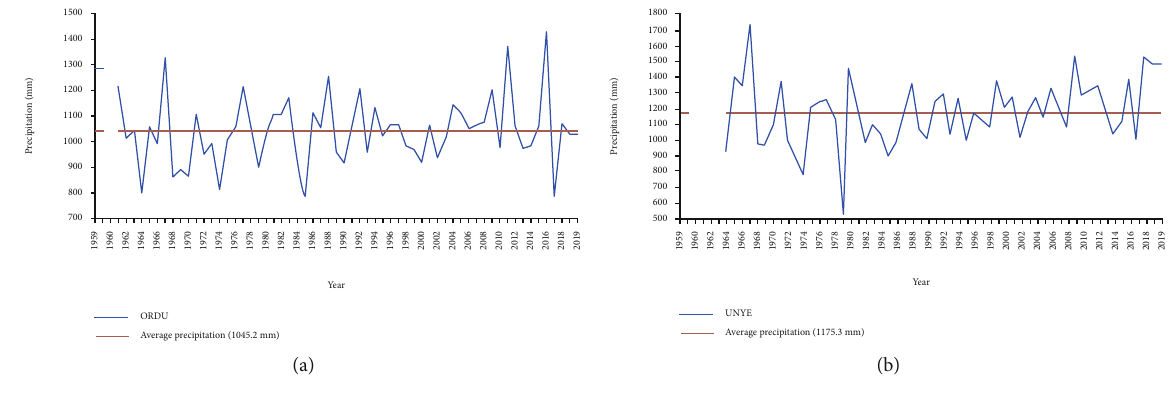
Figure 5: Long-term yearly precipitation statistics for (a) Ordu and (b) Unye Stations.